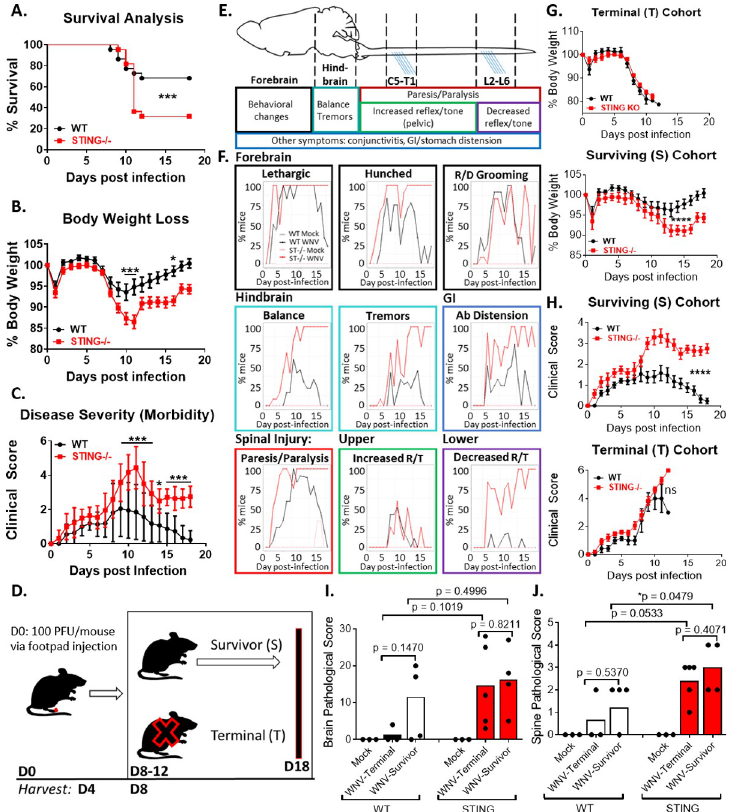
Fig 1. STING deficiency leads to increased morbidity and mortality during WNV infection in vivo. (A) Increased mortality in STING-/- mice. n = 22 per strain; Mantel-Cox analysis, p = 0.05 � ; p = 0.005 �� , p = 0.0005 ��� . (B-C) Body weight loss (B) and clinical scores (C) are more pronounced in STING-/- mice, indicating increased morbidity during WNV infection. n = 22 per strain; two-way ANOVA, Bonferroni posttest; p = 0.05 � ; p = 0.005 �� , p = 0.0005 ��� . (D) Schematic of infection and harvest time points. (E) Schematic of clinical signs and predicted pathology associated with WNV damage of the CNS. Anatomical model and clinical associations modified from previously described studies [85–89]. (F) Clinical signs observed during WNV infection of WT and STING-/- mice. R/D: ruffled/decreased; Ab: abdominal; R/T: reflex/tone. n = 10 per strain. (G) Body weight loss in (top) Terminal (T) vs (bottom) Survivor (S) cohorts. n = 22 per strain; two-way ANOVA, Bonferroni posttest; p = 0.05 � ; p = 0.005 �� , p = 0.0005 ��� . (H) Clinical score analysis in (top) Terminal (T) vs (bottom) Survivor (S) populations. n = 22 per strain; two-way ANOVA, Bonferroni posttest; p = 0.05 � ; p = 0.005 �� , p = 0.0005 ��� . (I-J) Pathological damage observed in the brains (I) spinal cord (J) by H&E staining in WT and STING-/- Terminal (T) and Survivor (S) mice. n = 3–9 per condition; students t- test (unpaired); p = 0.05 � ; p = 0.005 �� , p = 0.0005 ���